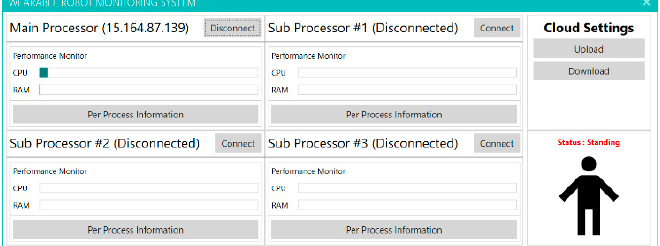
Figure 4. GWRMS server GUI client.